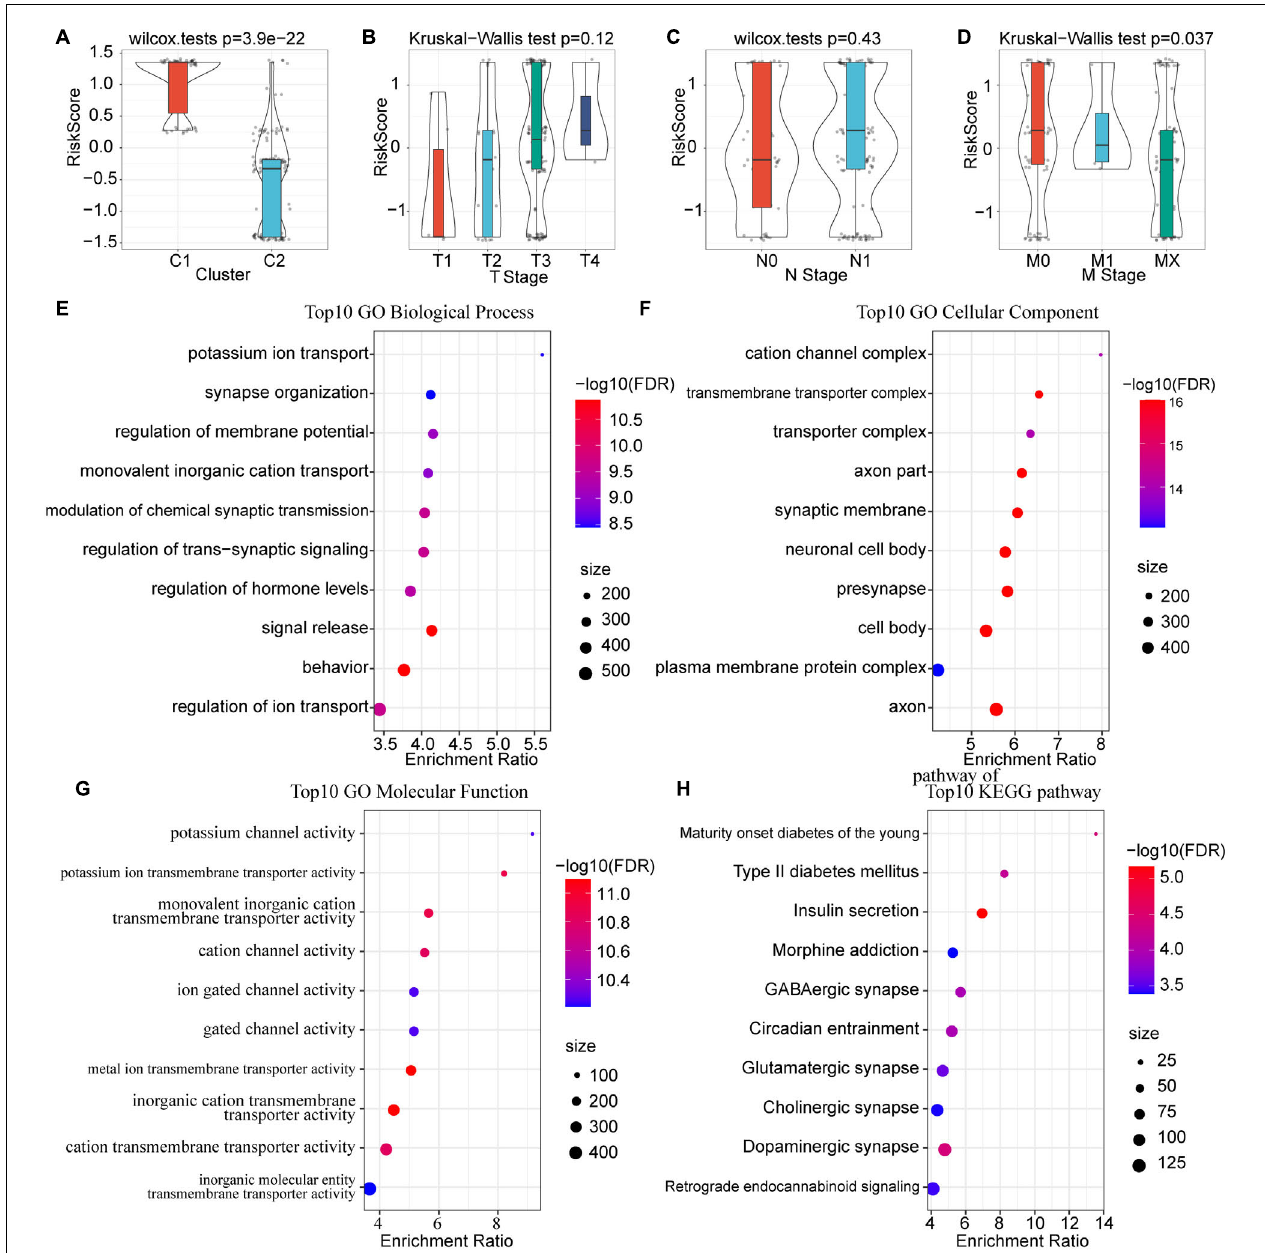
FIGURE 7 | Correlations among risk score, clinical characteristics and functional enrichment analysis. (A) Differences in risk scores between subtypes. (B) Differences in RiskScores for T stage. (C) Differences in RiskScores for N stage. (D) Differences in RiskScores for M stage. (E) Top 10 BP enrichment terms